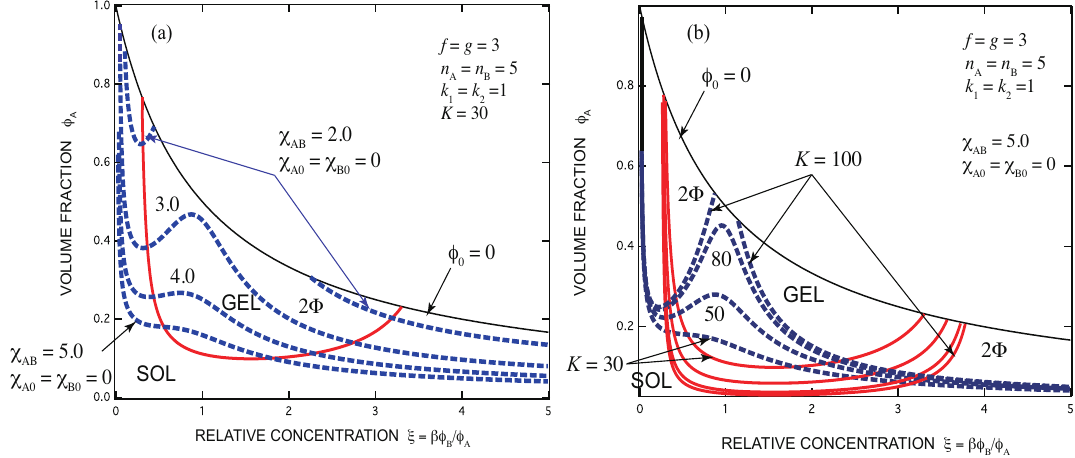
Figure 3. Sol-gel-sol transition lines (red solid lines) and spinodal lines (blue broken lines) for pairwise reaction k 1 = k 2 = 1 drawn on the ternary phase plane. The horizontal axis is the scaled concentration ξ of the secondary functional groups B, and the vertical axis is the volume fraction φ A of the primary functional groups A. The upper bound of the graph (thin solid line) shows the limiting solution without solvent. The functionalities are fixed at f = g = 3. The number of repeat units are fixed at n A = n B = 5. ( a ) The interaction parameter χ A , B between A and B molecules is changed from 2.0 to 5.0 while the association constant is fixed at K = 30. The two phase region is indicated by 2 Φ . ( b ) The same as ( a ) but the association constant is changed from 30 to 100 while the interaction parameter is fixed at χ A , B =